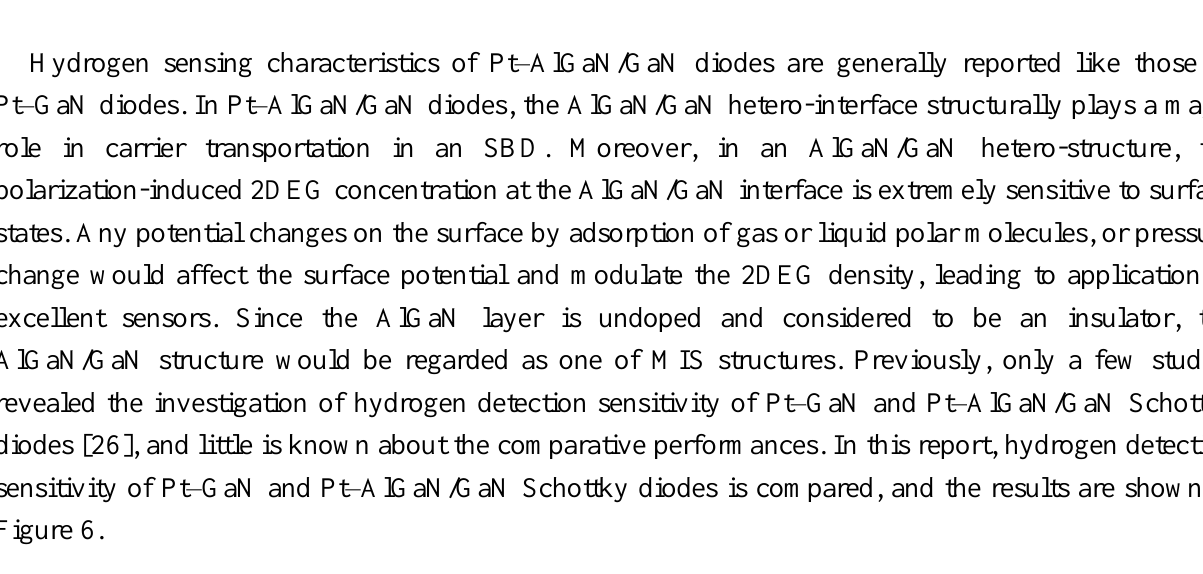
Figure 6. I–V characteristics of Pt–GaN diode (a) and Pt–AlGaN/GaN diode (b) in N response to exposure to 1% H